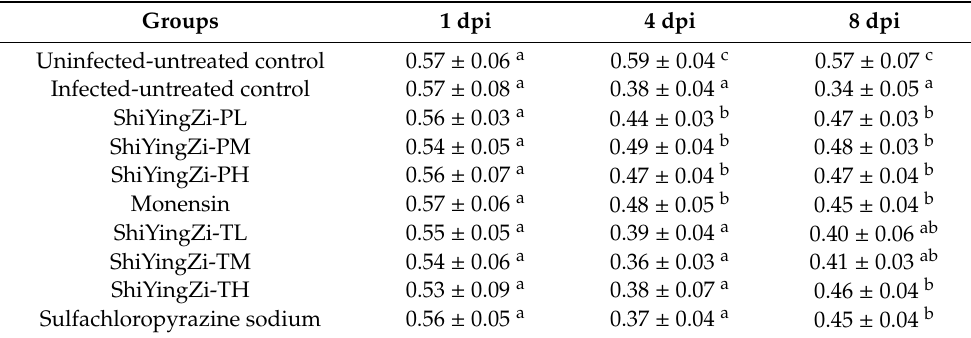
Table 7. Triglyceride content (mmol / L).